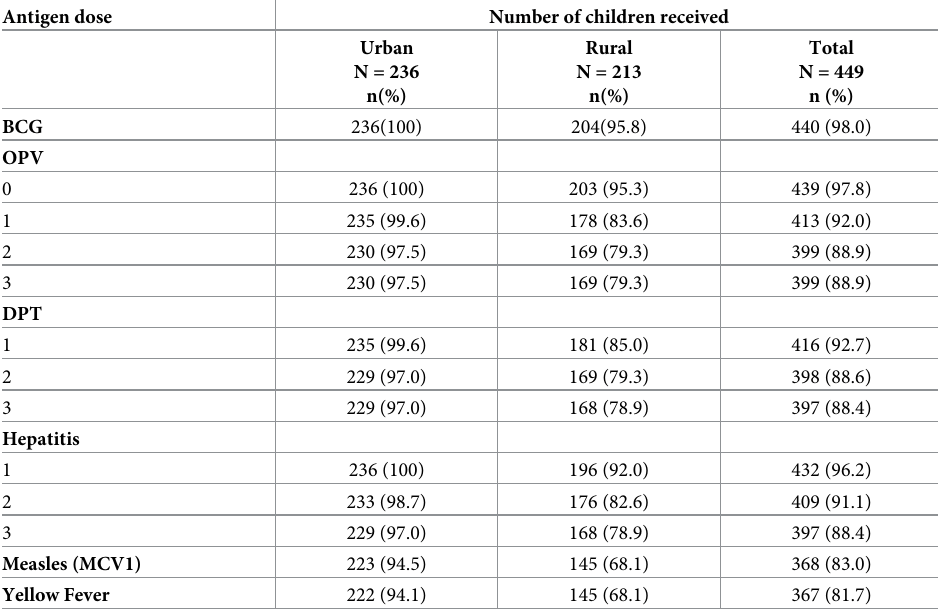
Table 3. Distribution of children who received each antigen by location, Akinyele LGA, Oyo State, Nigeria–